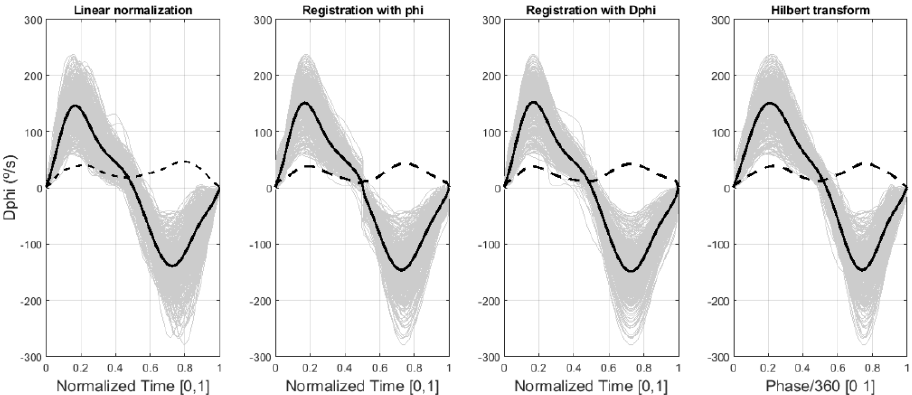
Figure 4. Normalized velocity (Dphi) curves for the four methods compared, together with their functional means (solid black line) and functional standard deviations (dashed black line).